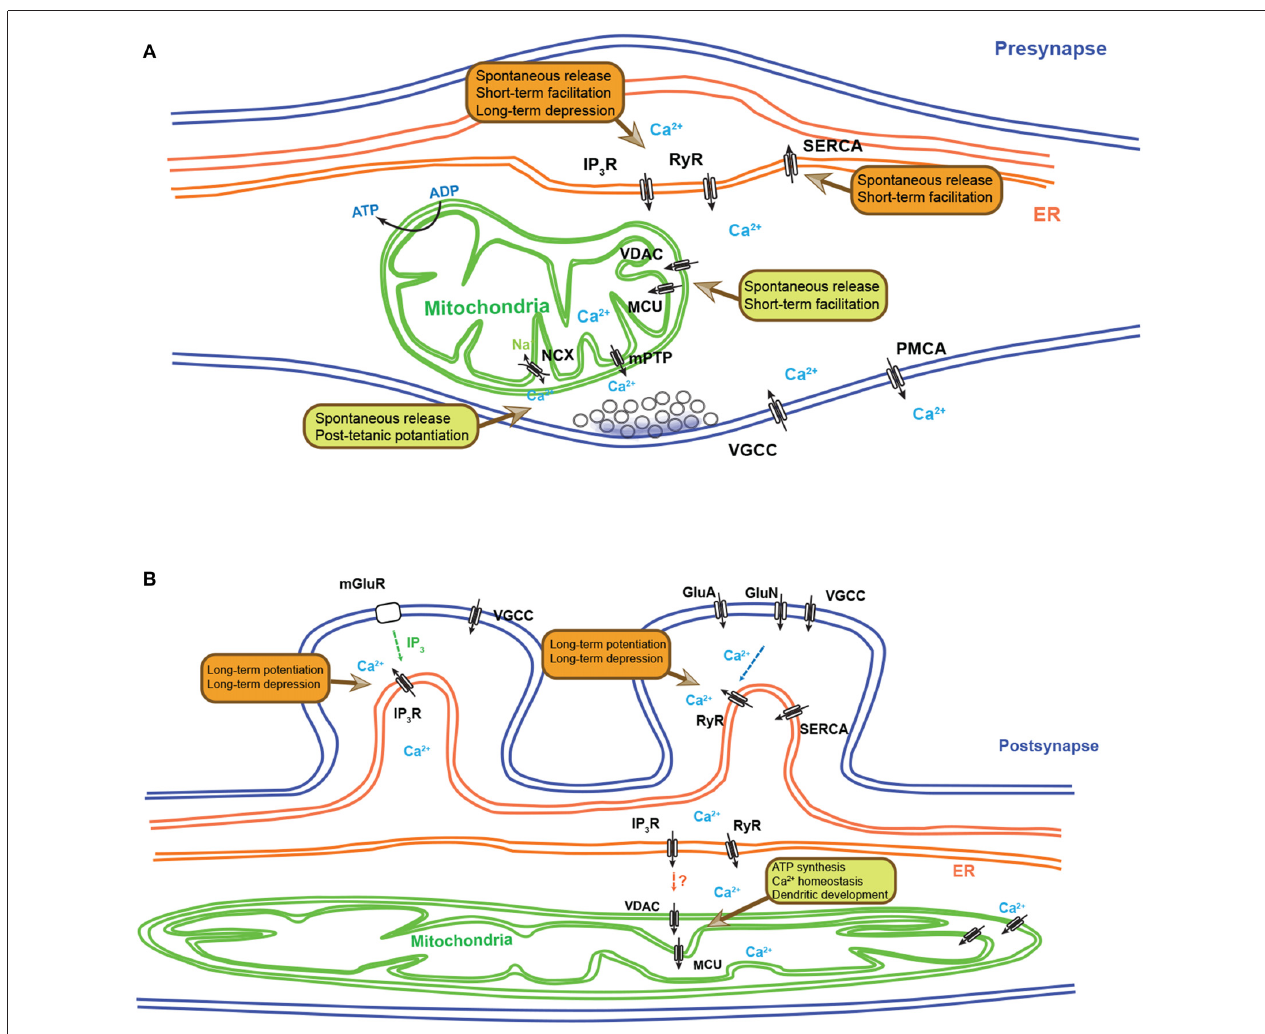
FIGURE 1 | Synaptic functions regulated by endoplasmic reticulum (ER) and mitochondria-dependent Ca 2+ homeostasis. (A) Schematic diagram depicting the presynaptic functions regulated by ER- and mitochondria-dependent Ca 2 + dynamics. Ca 2 + release from ER can modulate spontaneous neurotransmitter release, short-term facilitation (STF) and long-term depression (LTD). Ca 2 + re-uptake by the ER controls the spontaneous release and STF. Presynaptic mitochondria also play important roles in regulating spontaneous neurotransmitter release, STF and post-tetanic potentiation (PTP) through their ability to regulate Ca 2 + clearance. (B) A simplified schematic diagram depicting the postsynaptic functions regulated by ER- and mitochondria-dependent Ca 2 + dynamics. Ca 2 + release from ER via IP 3 -induced Ca 2 + release (IICR) and Ca 2 + -induced Ca 2 + release (CICR) controls long-term potentiation (LTP) and LTD. In fact,